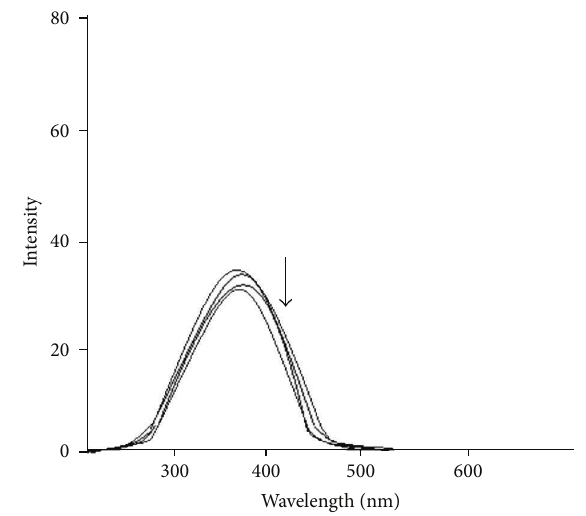
Figure 5: Fluorescence spectra of DNA-EB (10mM) in the presence of 0, 15, 25, and 35 mM of complex 2. Arrow shows the changes in the emission intensity as a function of complex concentration.